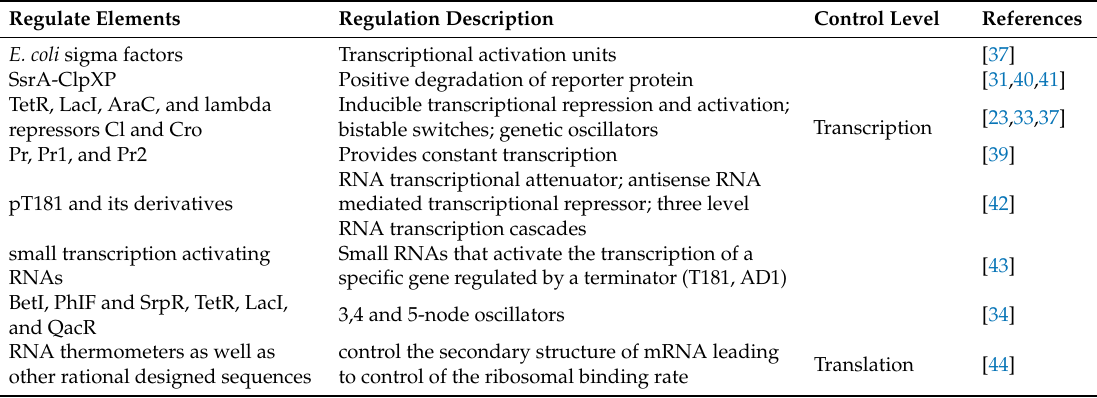
Table 1. Regulate motifs tested in the CFPS system and their regulatory